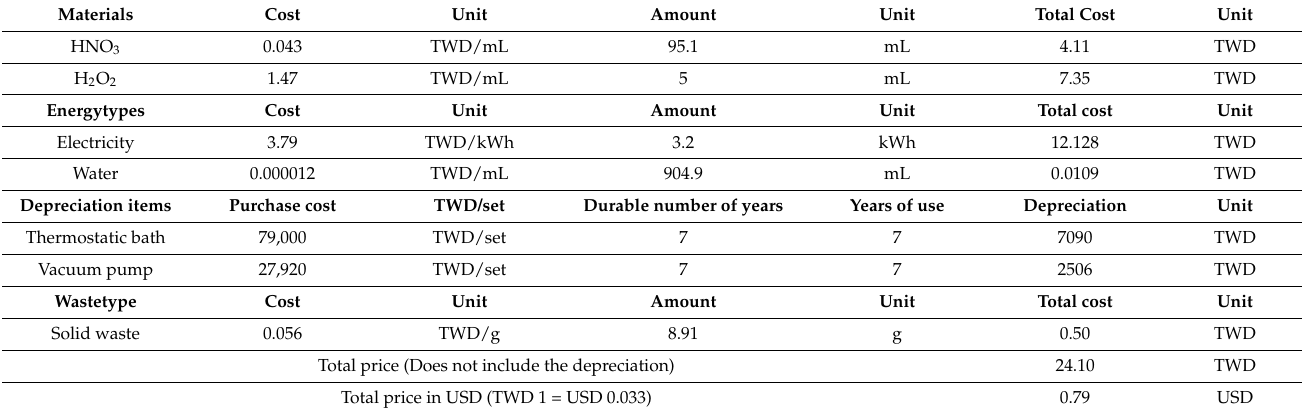
Table 9. Nitric acid leaching